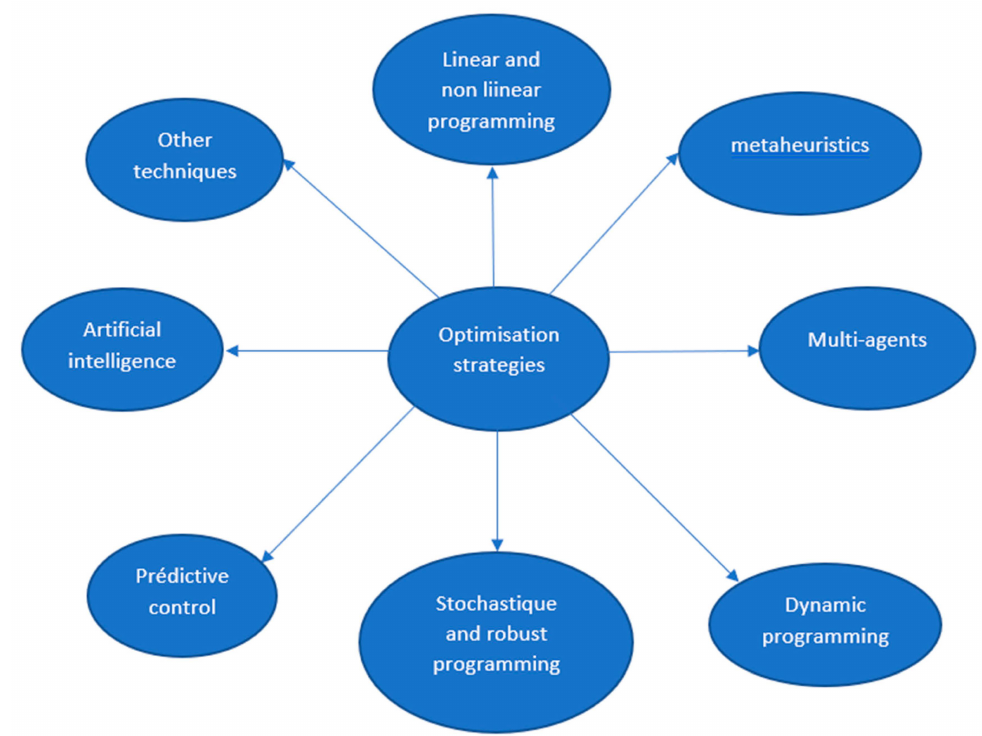
Figure 6. Some optimization